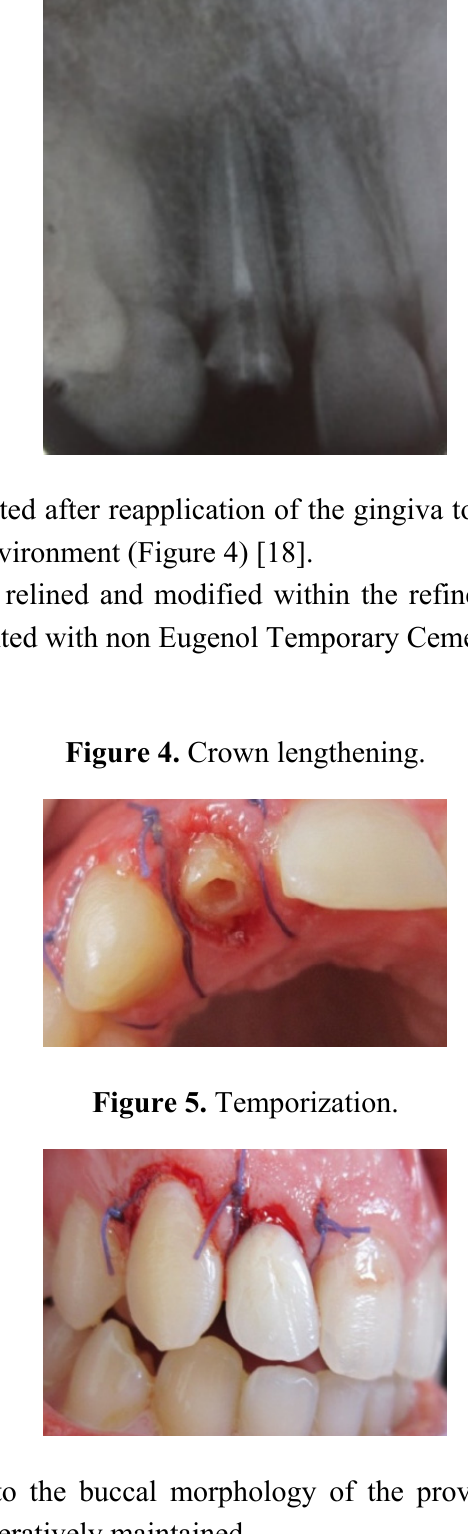
Figure 3. Radiological reevaluation showing the distance between crestal bone and inter proximal preparation level.